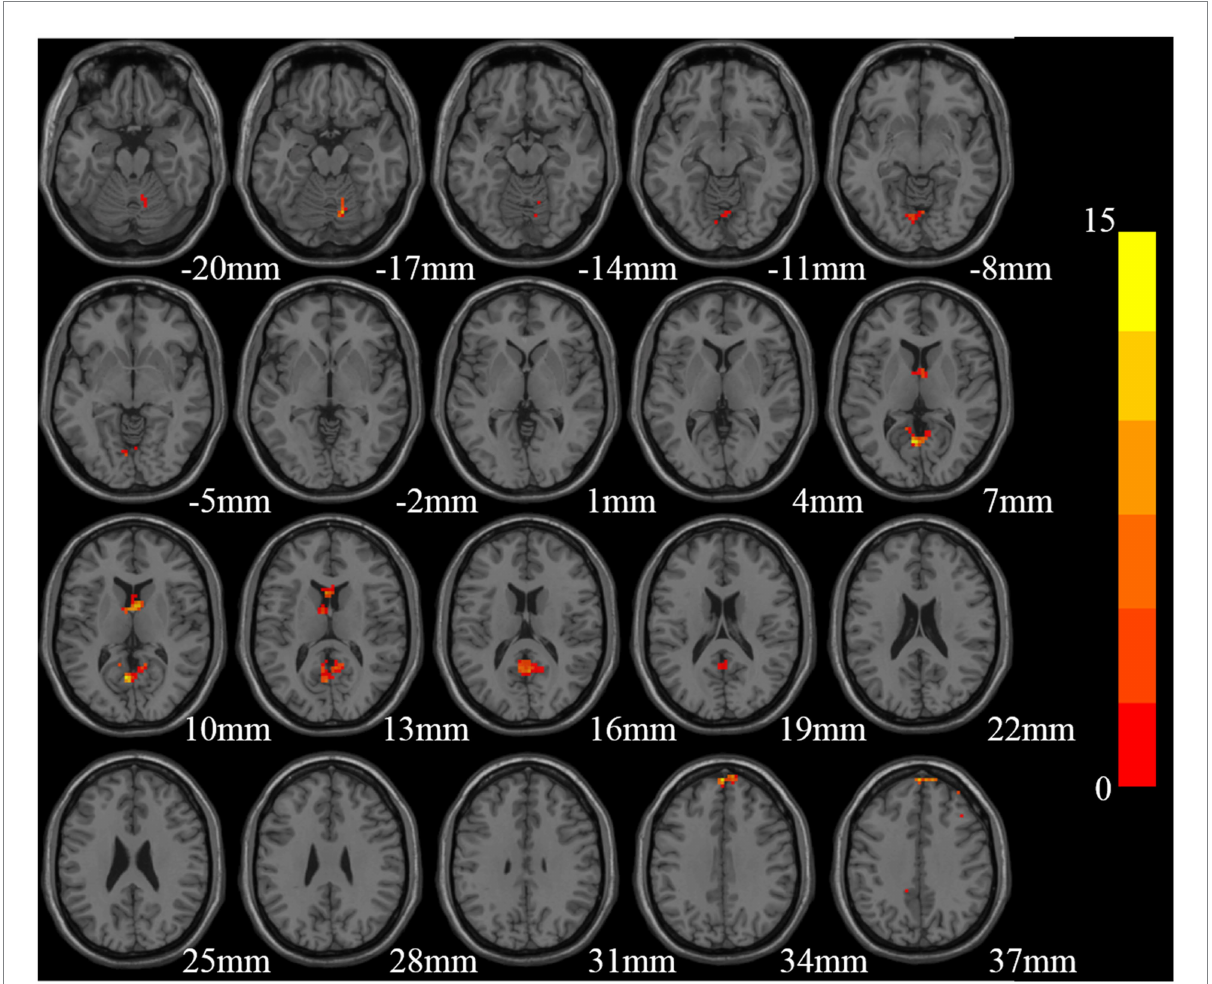
FIGURE 1 Brain regions with significant differences in Reho among the three groups [Gaussian random field (GRF) multiple comparison correction, P < 0.01 at the voxel level and P < 0.05 at the cluster level].